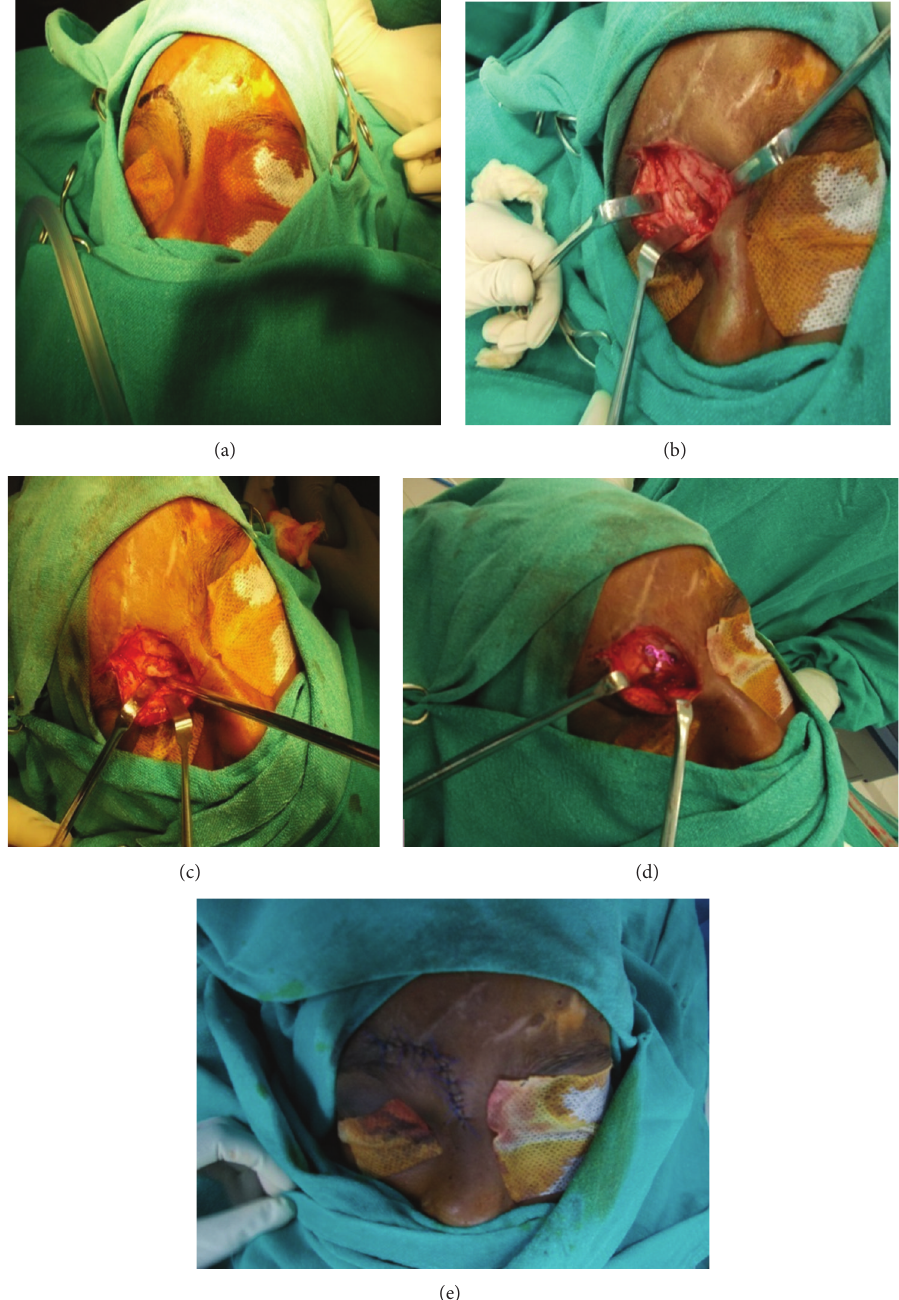
Figure 3: (a) Marking for the incision. (b) Fracture site exposed. (c) Reducing the segment manually with Howarth’s periosteal elevator. (d) Open reduction and internal fixation with titanium plate and screws. (e) Layerwise closure